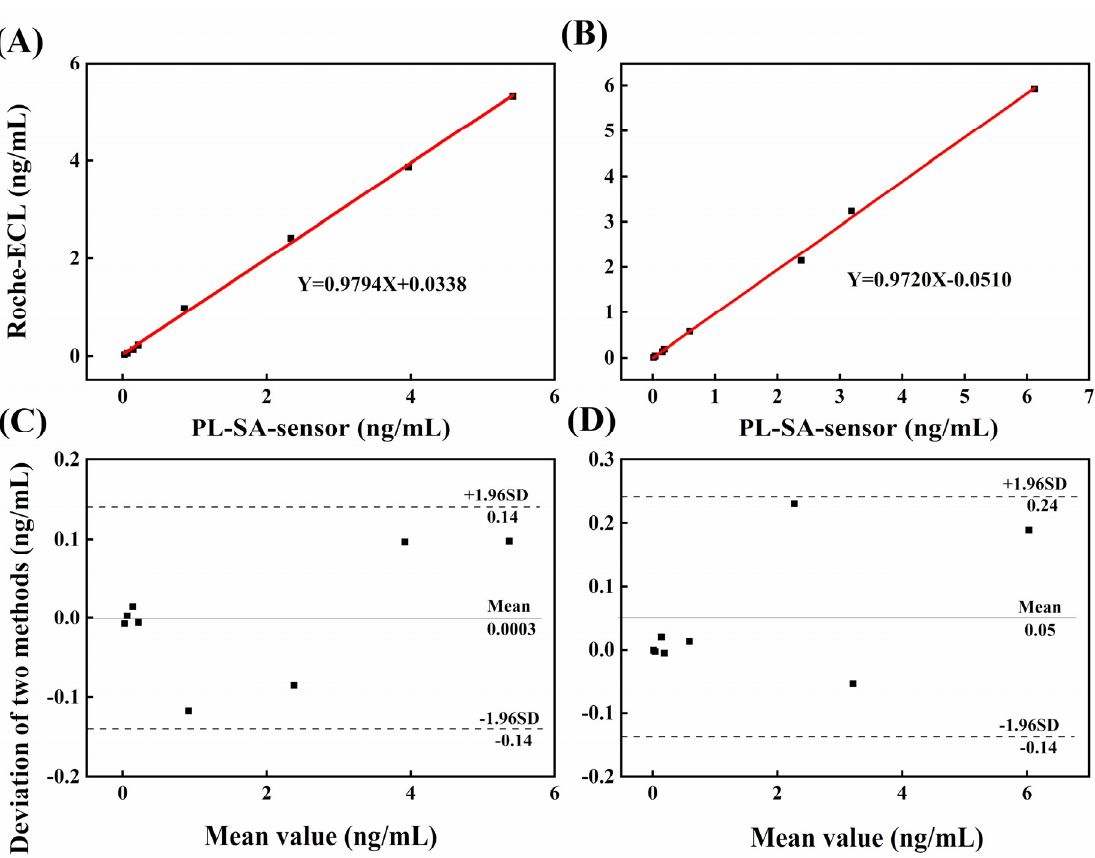
Figure 6. Correlation and Bland-Altman analysis for the agreement between the proposed PL-SA-sensor and the Roche-ECL tests for the immunoassay of HBeAg ( A , C ) and HBsAg ( B , D ) in human serum samples. Data shows a 95% confidence interval of the mean for 8 serum samples.